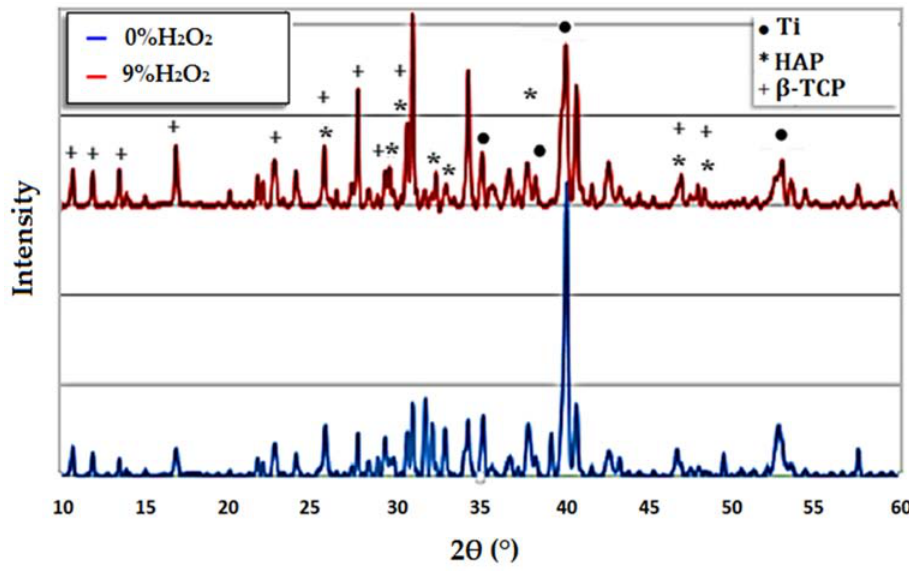
Figure 6. XRD diffractograms of the heat-treated HAP coating obtained with 0% and 9% of H 2 O 2 .